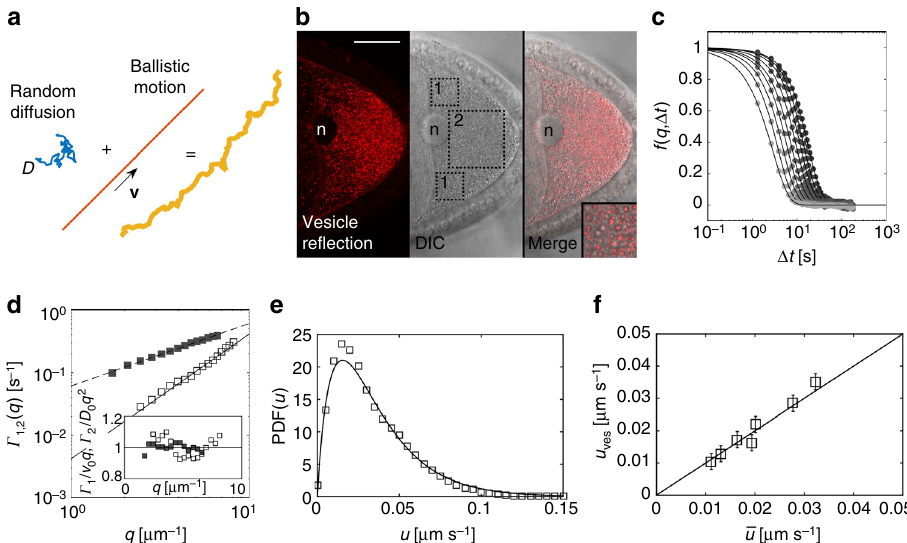
Fig. 1 Movement of cytoplasmic vesicles consists of persistent and diffusive motions. a Diagram, depicting the motion of cytoplasmic particles by random diffusion, described by a characteristic diffusion coef fi cient D (blue), and a persistent, ballistic motion, described by a characteristic velocity v (red). Both together result in the persistent, erratic movement of tracer particles observed in the cell (orange). b Confocal image showing re fl ection of vesicles in a st9 oocyte (left panel), and the same vesicles imaged by DIC microscopy (middle panel). The merge of both signals reveals that the re fl ective signal co-localizes with the center of vesicles (right panel, inset). The boxed areas indicate anterior (1) and posterior (2) regions of interest (ROI), used to refer positional differences of diffusivity and streaming velocities. As expected, fl ow velocities in the anterior part of the cell are markedly faster than posteriorly (anterior v ves = 45 ± 10 nm s − 1 vs. posterior v ves = 28 ± 5 nm s − 1 ). n nucleus. Scale bar is 30 μ m. c Intermediate scattering functions (ISF) f ( q , Δ t ), obtained from DIC – DDM analysis for different wave vectors q in the range 1.8 µ m − 1 < q < 8 µ m − 1 . Continuous lines are best fi ts to Eq. (1). d Decorrelation rates Γ 1 ( q ) (solid black boxes) and Γ 2 ( q ) (open boxes) obtained from the fi t of the ISF, represented in c , plotted against the wave vector q . Γ 1 ( q ), which accounts for the ballistic contribution to the motion of the vesicles, exhibits a linear scaling Γ 1 ( q ) = v ves q (dashed line), while Γ 2 ( q ), which describes a diffusive-like relaxation process, is well fi tted to a quadratic law Γ 2 ( q ) = D ves q 2 (continuous line). In the inset, the ratios Γ 1 ( q )/( v ves q ) (solid black boxes) and Γ q )/( D q 2 ) (open boxes) are reported, showing no systematic deviations from the expected value (1) and an overall moderate fl uctuation ( < 10%). 2 ( ves e Probability distribution function (PDF) of the 2D streaming speed in a single cell, as obtained from PIV analysis (open boxes) and as reconstructed from DIC – DDM analysis (solid line). f Comparison of 2D mean streaming speeds obtained by DIC – DDM ( u ves ) and PIV u ð Þ for each cell tested. Both values are in good agreement (solid line represents u ves ¼ u ), validating DIC – DDM as reliable tool to quantify cytoplasmic fl ows. Error bars are standard